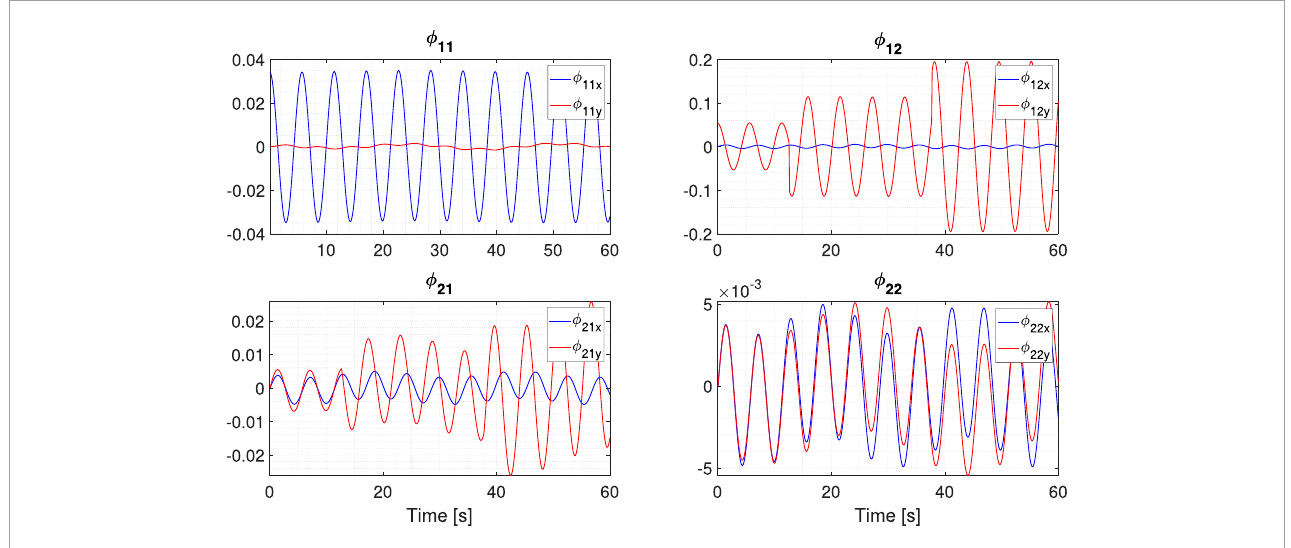
FIGURE 5 Evolution of the time-dependent terms for the observer based on the nested super-twisting algorithm.